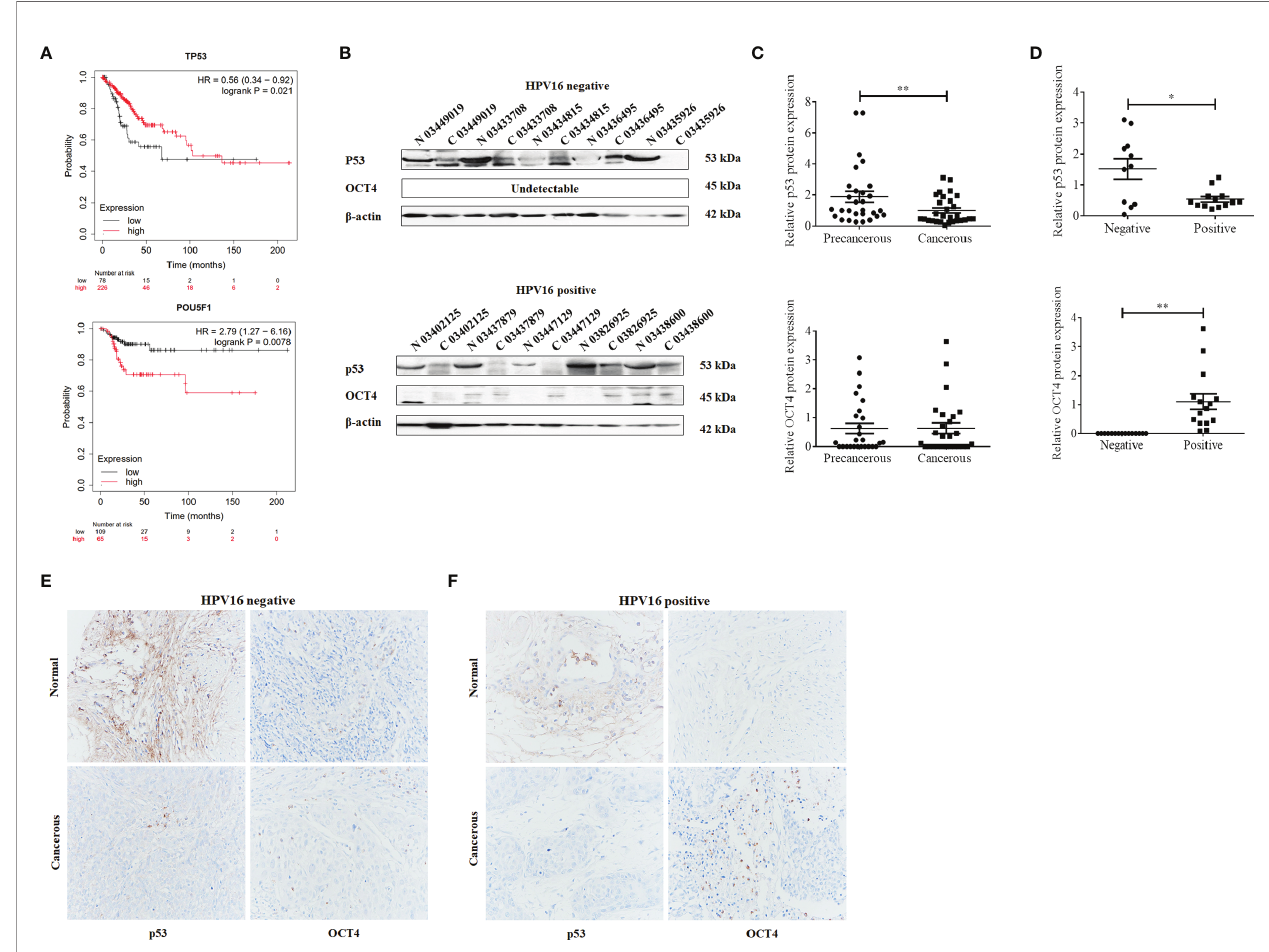
FIGURE 1 | Octamer-binding transcription factor 4 (OCT4) and p53 expression and their clinical signi fi cance in cervical cancer. (A) The association between the expression level of OCT4 or p53 and the overall survival rate of cervical cancer patients. Data were obtained from the Kaplan – Meier Plotter database. (B) Western blot analysis of OCT4 and p53 expression in human cervical cancer tissues and precancerous ones. (C, D) Statistical analysis of OCT4 and p53 protein expression in HPV16-negative or HPV16-positive human cervical cancer tissues by the WB assay. (E, F) Graphs showing OCT4 and p53 expression in HPV16-negative or